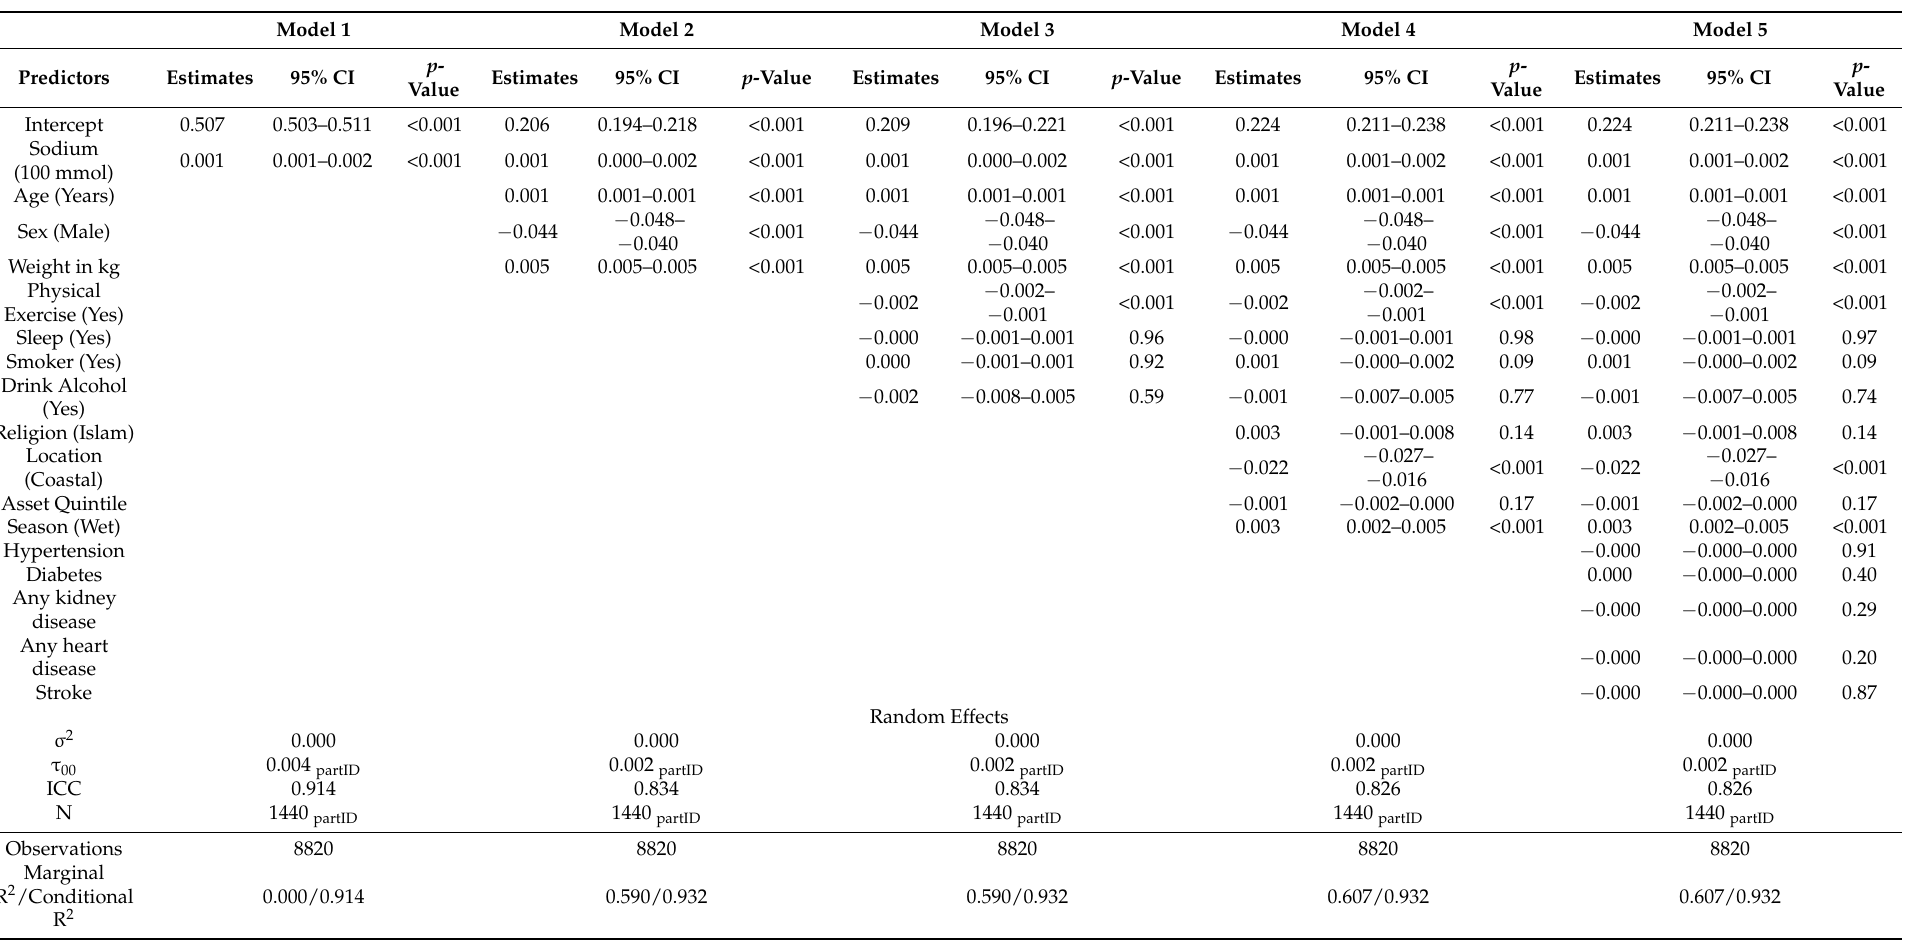
Table 5. Association between 24 h urinary sodium and mean waist-to-height